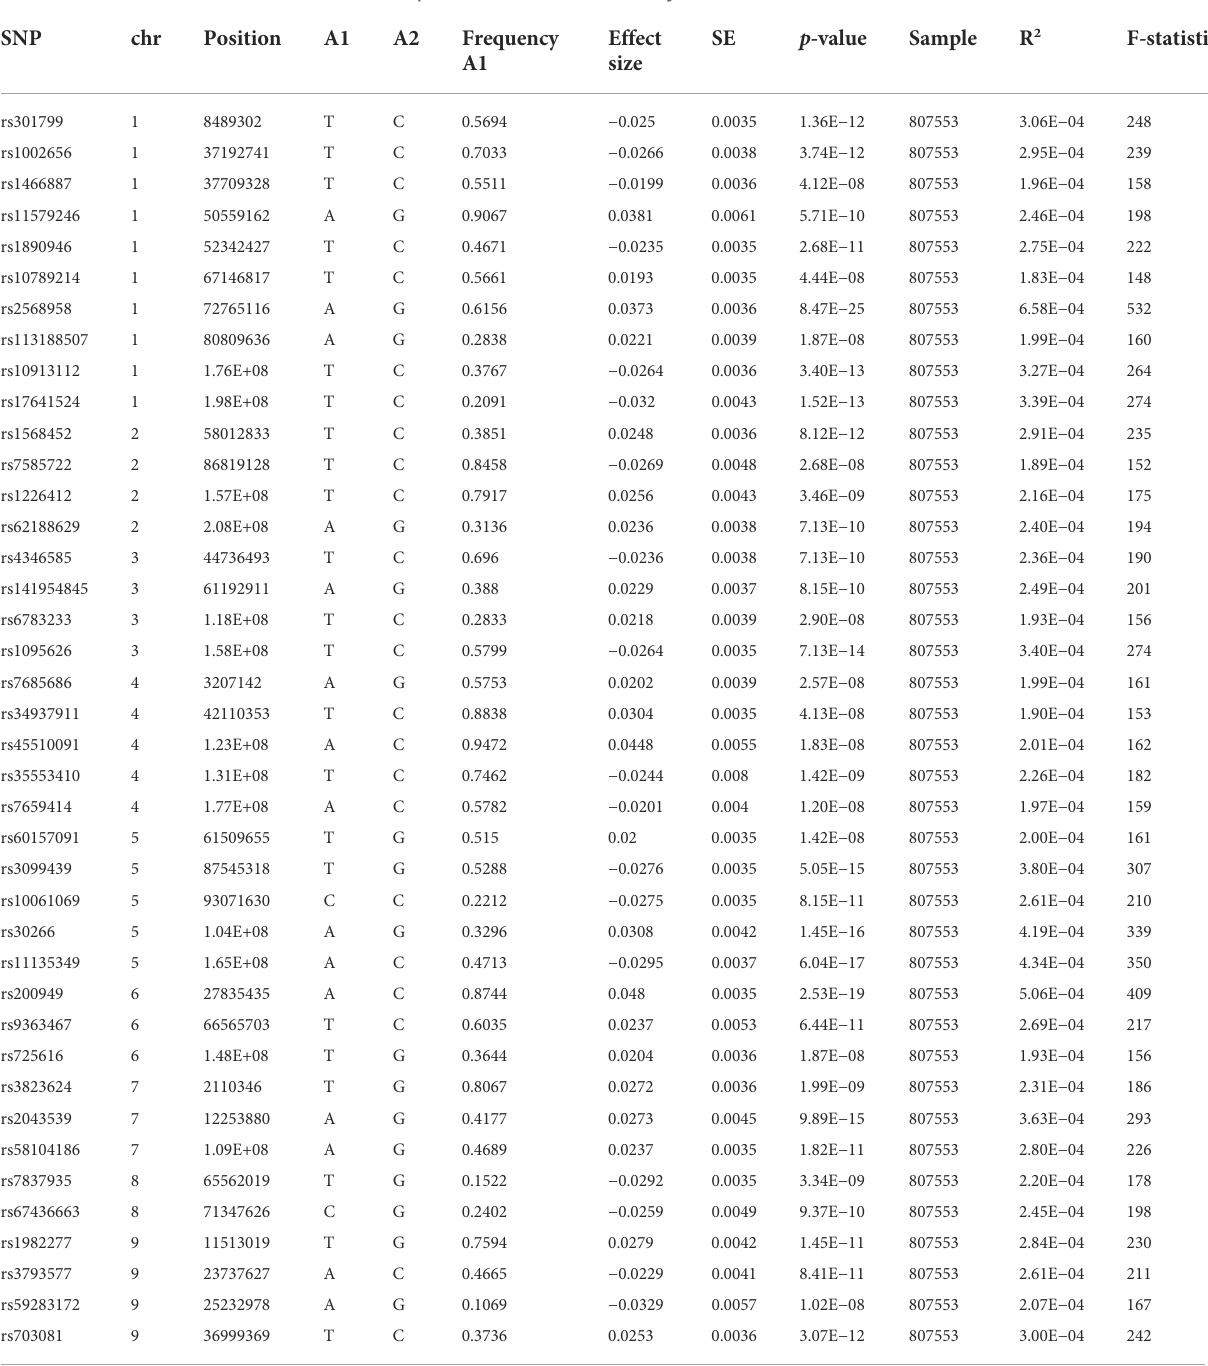
TABLE 1 SNPs used as instrumental variables of depression on ED in the MR